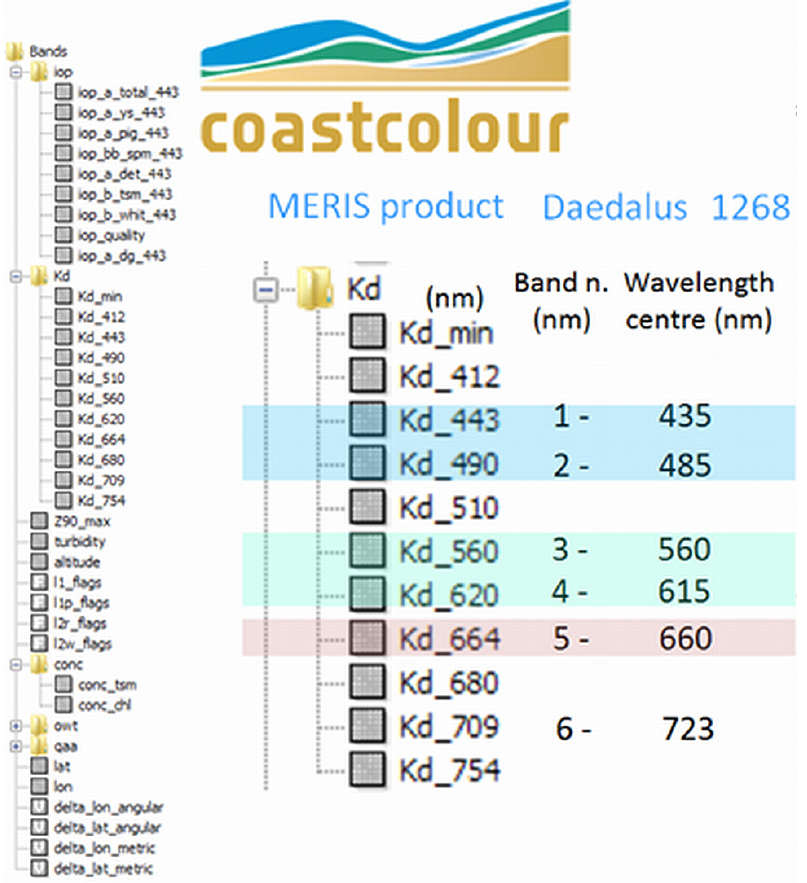
Figure 6. Coastcolour MERIS thematic products included the K corresponding to Daedalus ATM 1268E bands (within the colored